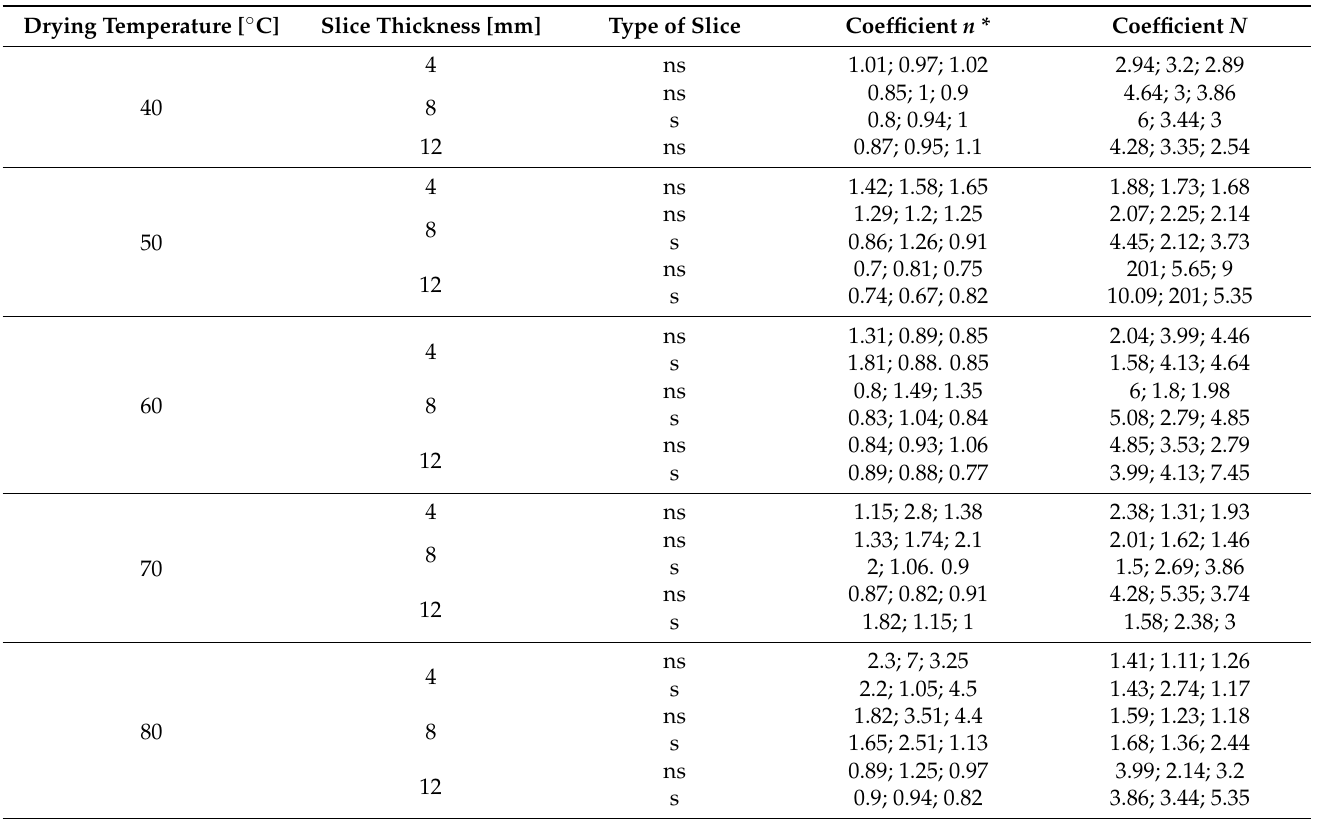
Table 1. Coefficients n and N of the model (6) depending on the parameters of the drying process.